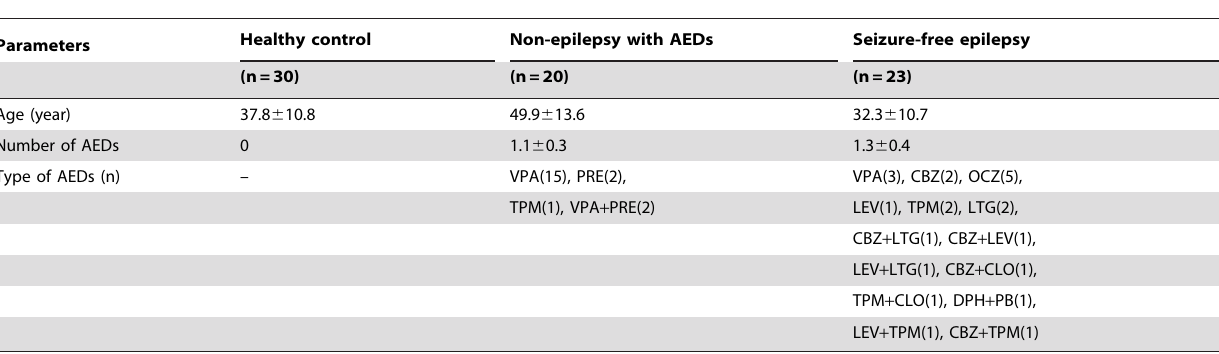
Table 2. Control groups characteristics.